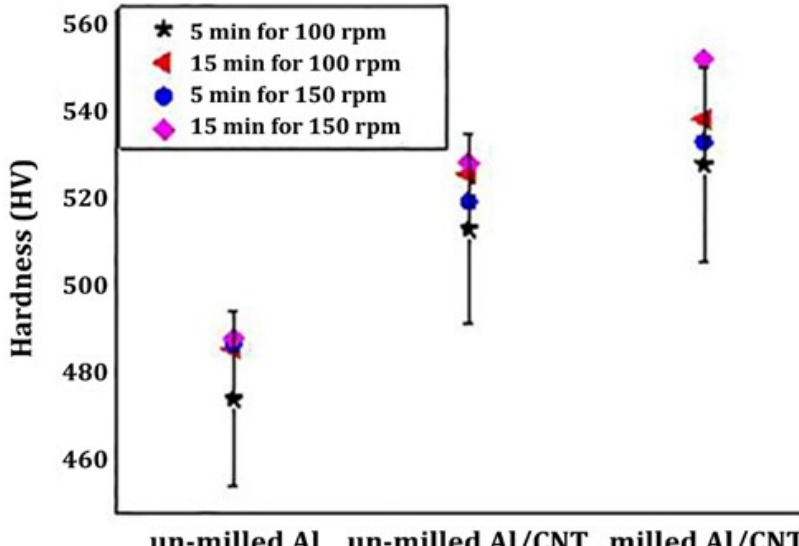
Figure 9. Hardness of Al/CNT nanocomposite [88]. (Permissions to use this Figure is granted since the source article is an open access distributed under the terms and conditions of the Creative Commons Attribution (CC By) license (http://Creativecommons.org/license/by/4.0/ (accessed on 26 July